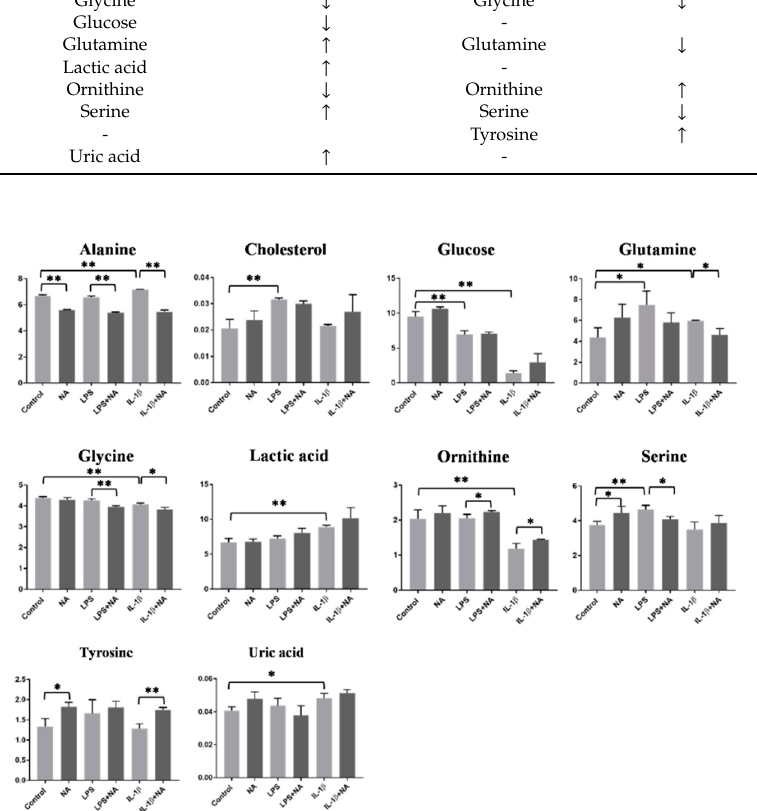
Figure 4. Significantly different extracellular metabolites measured in the medium of Caco-2 cell by 1 H-NMR and GC-MS. Metabolites are presented as peak areas normalized for total protein content and total area ( n = 3). Statistical analysis was performed using an unpaired Student’s t -test. * p < 0.05, ** p < 0.01.